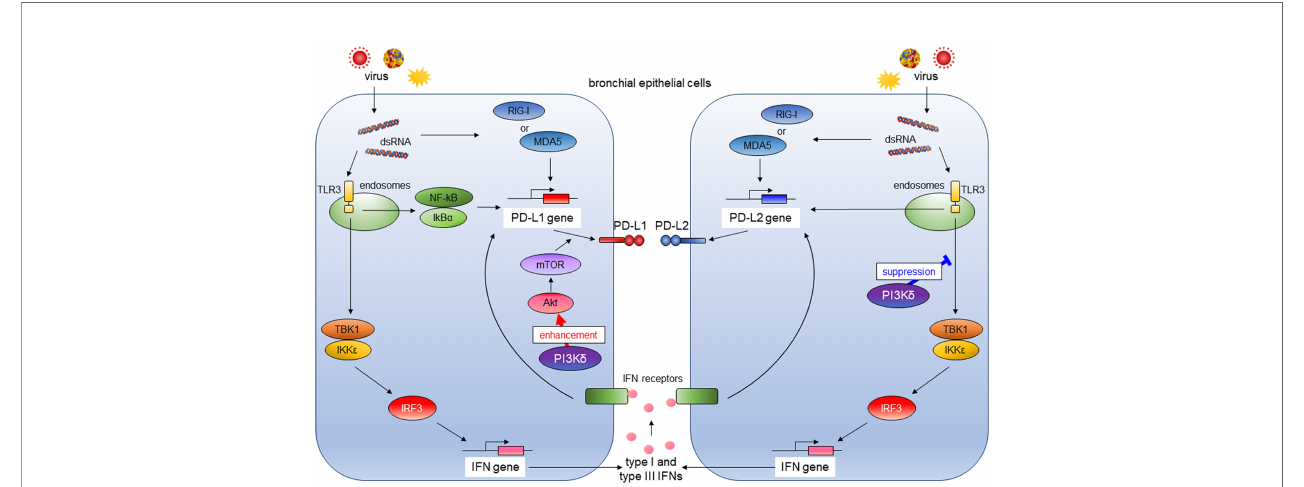
FIGURE 9 | The role of PI3K d in antiviral IFN responses and virus-induced expression of PD-L1 and PD-L2 in bronchial epithelial cells. RIG-I, retinoic acid-inducible gene I; MDA5, melanoma Differentiation-Associated protein 5; TLR3, toll-like receptor 3; NF- k B; the nuclear factor kappa B, I k B a ; inhibitory kappa B a , TBK1, the TANK-binding kinase-1; IKK ϵ , inhibitor of k B kinase ϵ ; IRF3, IFN regulatory factor 3; Akt, v-akt murine thymoma viral oncogene homolog; mTOR, the mechanistic target of